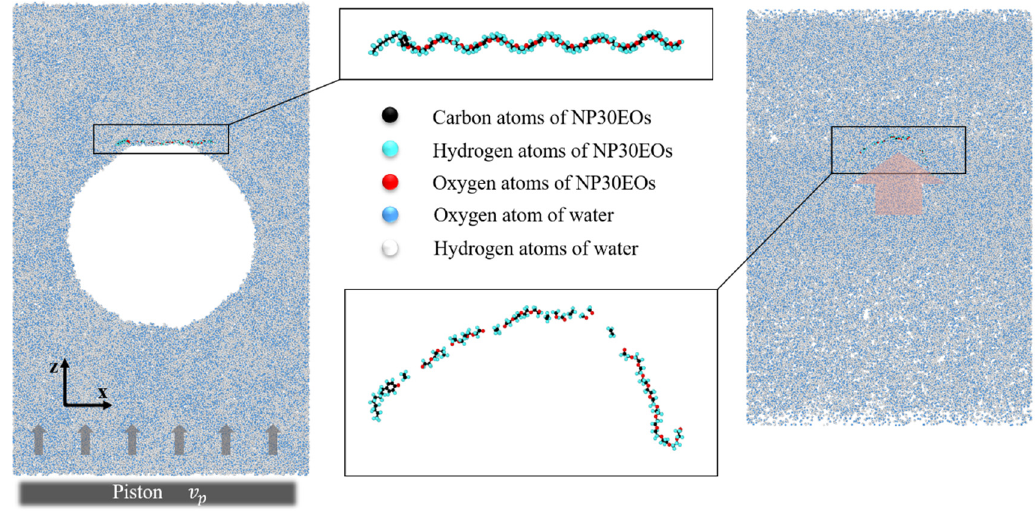
Figure 1. The initial configuration for a vacuum nanobubble system ( left ) and a typical configuration after the collapse of the nanobubble induced by the added shock wave ( right ). Magnified views of corresponding morphologies of the pollutant molecule, NP30EOs, are also shown ( middle ).